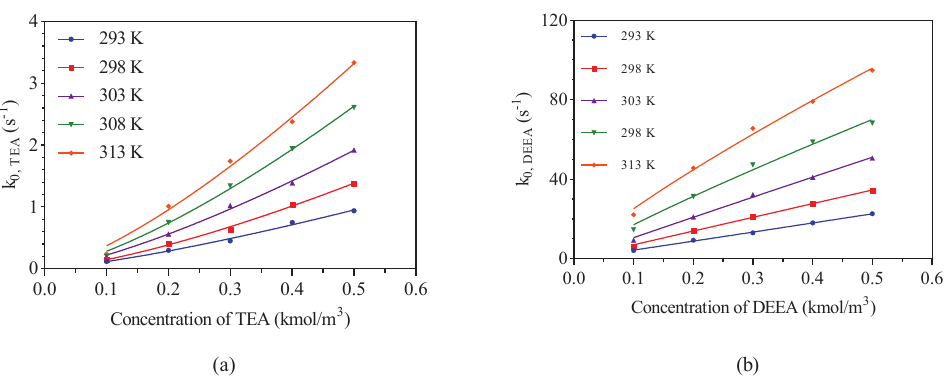
Figure 3. The k 0, amine values of CO peratures of 293–313 K: ( a ) represents TEA–CO